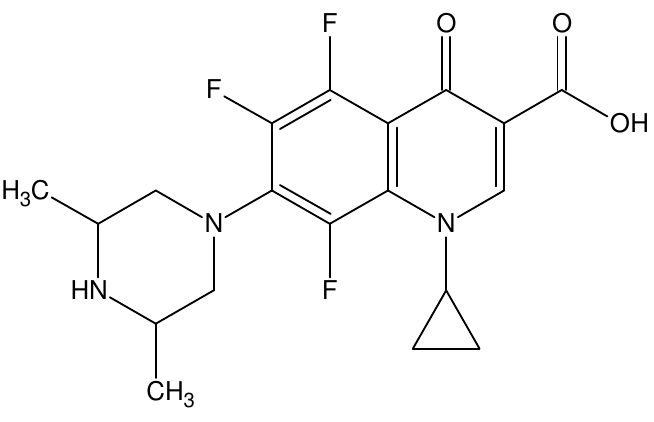
Figure 1. Chemical structure of orbifloxacin (CAS